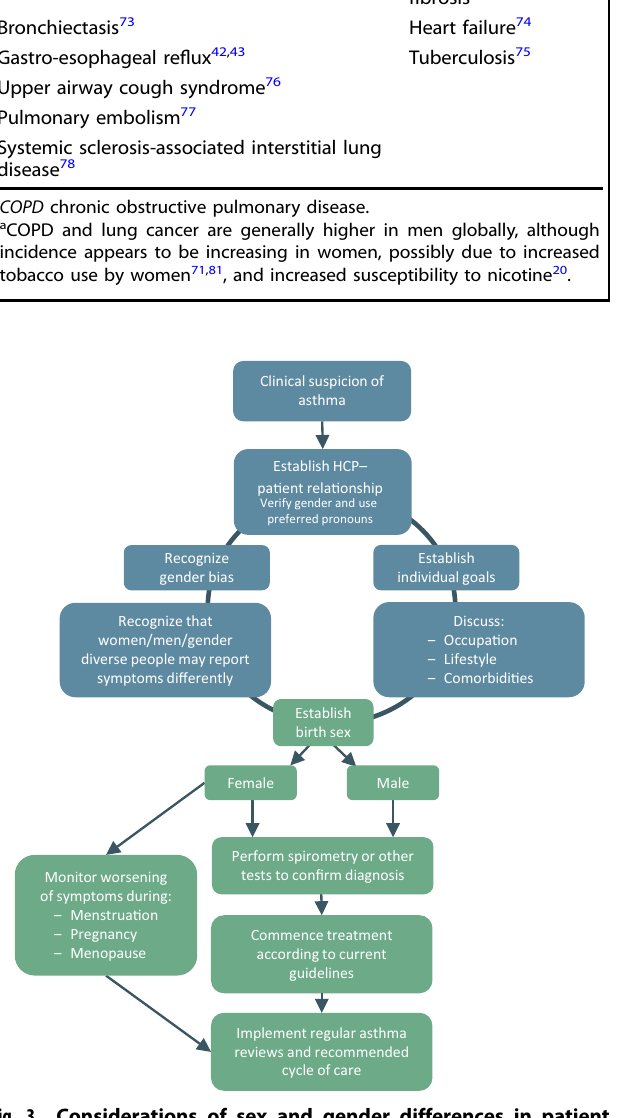
Fig. 3 Considerations of sex and gender differences in patient asthma management. HCP healthcare